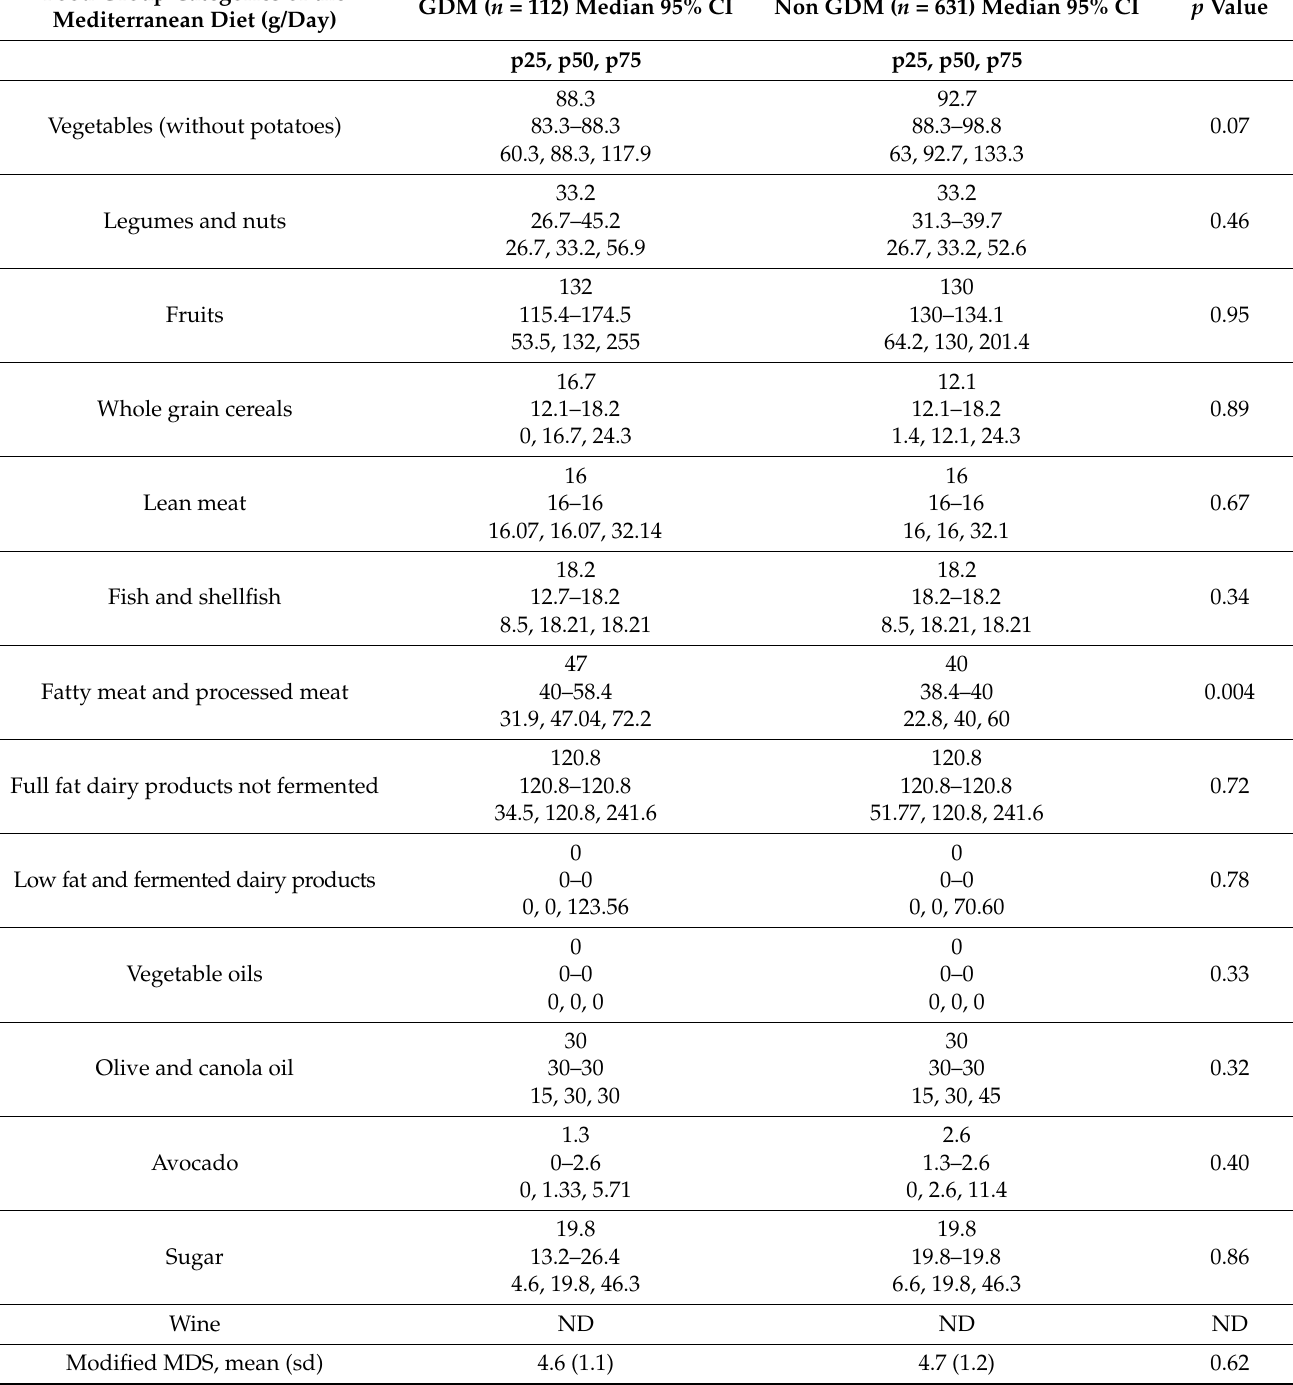
Table 3. Food group categories of the Mediterranean diet and mean consumption in the two groups, GDM and non GDM, using the modified MDS